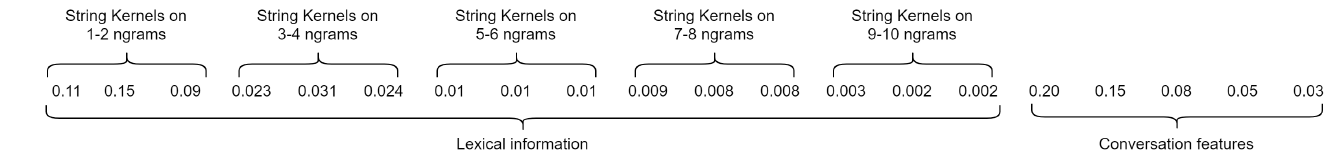
Figure 4. Gini feature importance for random forest with string kernels replacing semantic information.